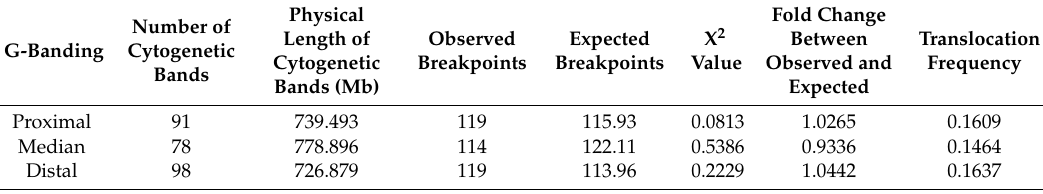
Table 5. The distribution of breakpoints by chromosomal position.